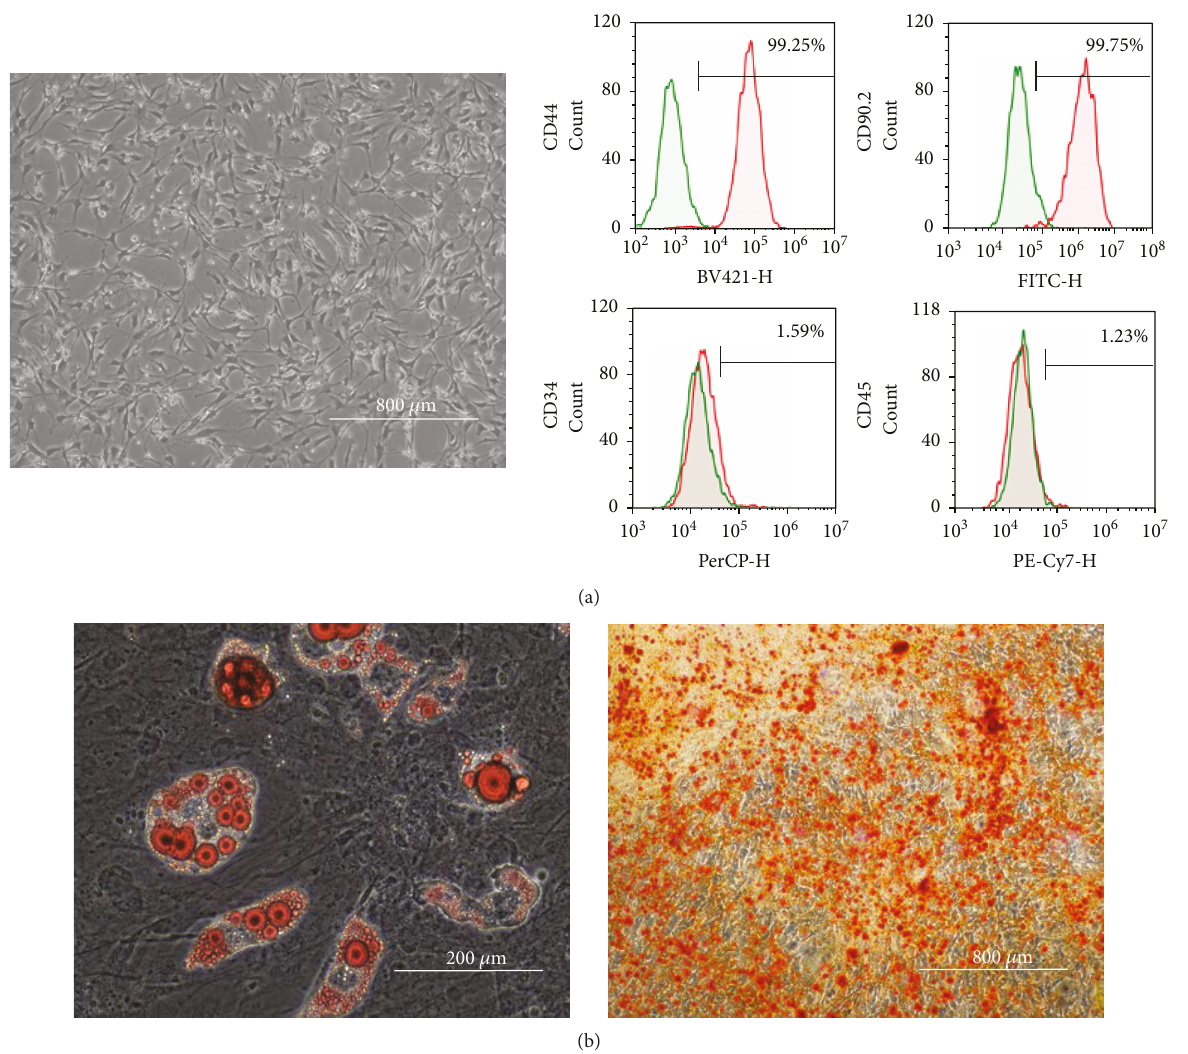
Figure 2: Phenotype and di ff erentiation potential of ADSCs isolated without preservation, which served as control group. Morphological appearance of ADSCs (passage 2) (a, left panel) and cell surface markers of ADSCs by fl ow cytometry (passage 2) (a, right panel). Representative images of adipocyte (b, left panel) and osteocyte di ff erentiation (b, right panel) from mouse ADSCs (passage 2) cultured in di ff erentiation